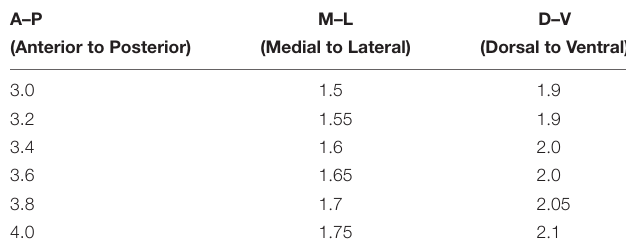
TABLE 1 | Coordinates (in mm) for RV